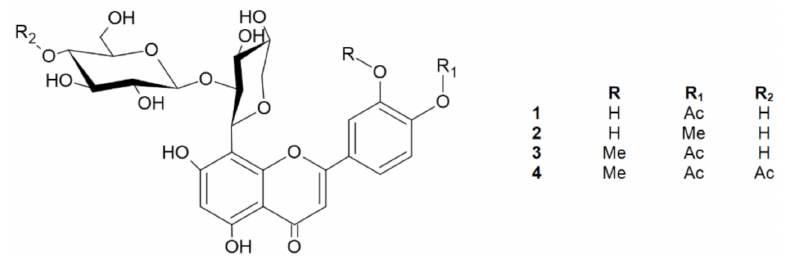
Figure 1. Chemical structures of compounds 1–4